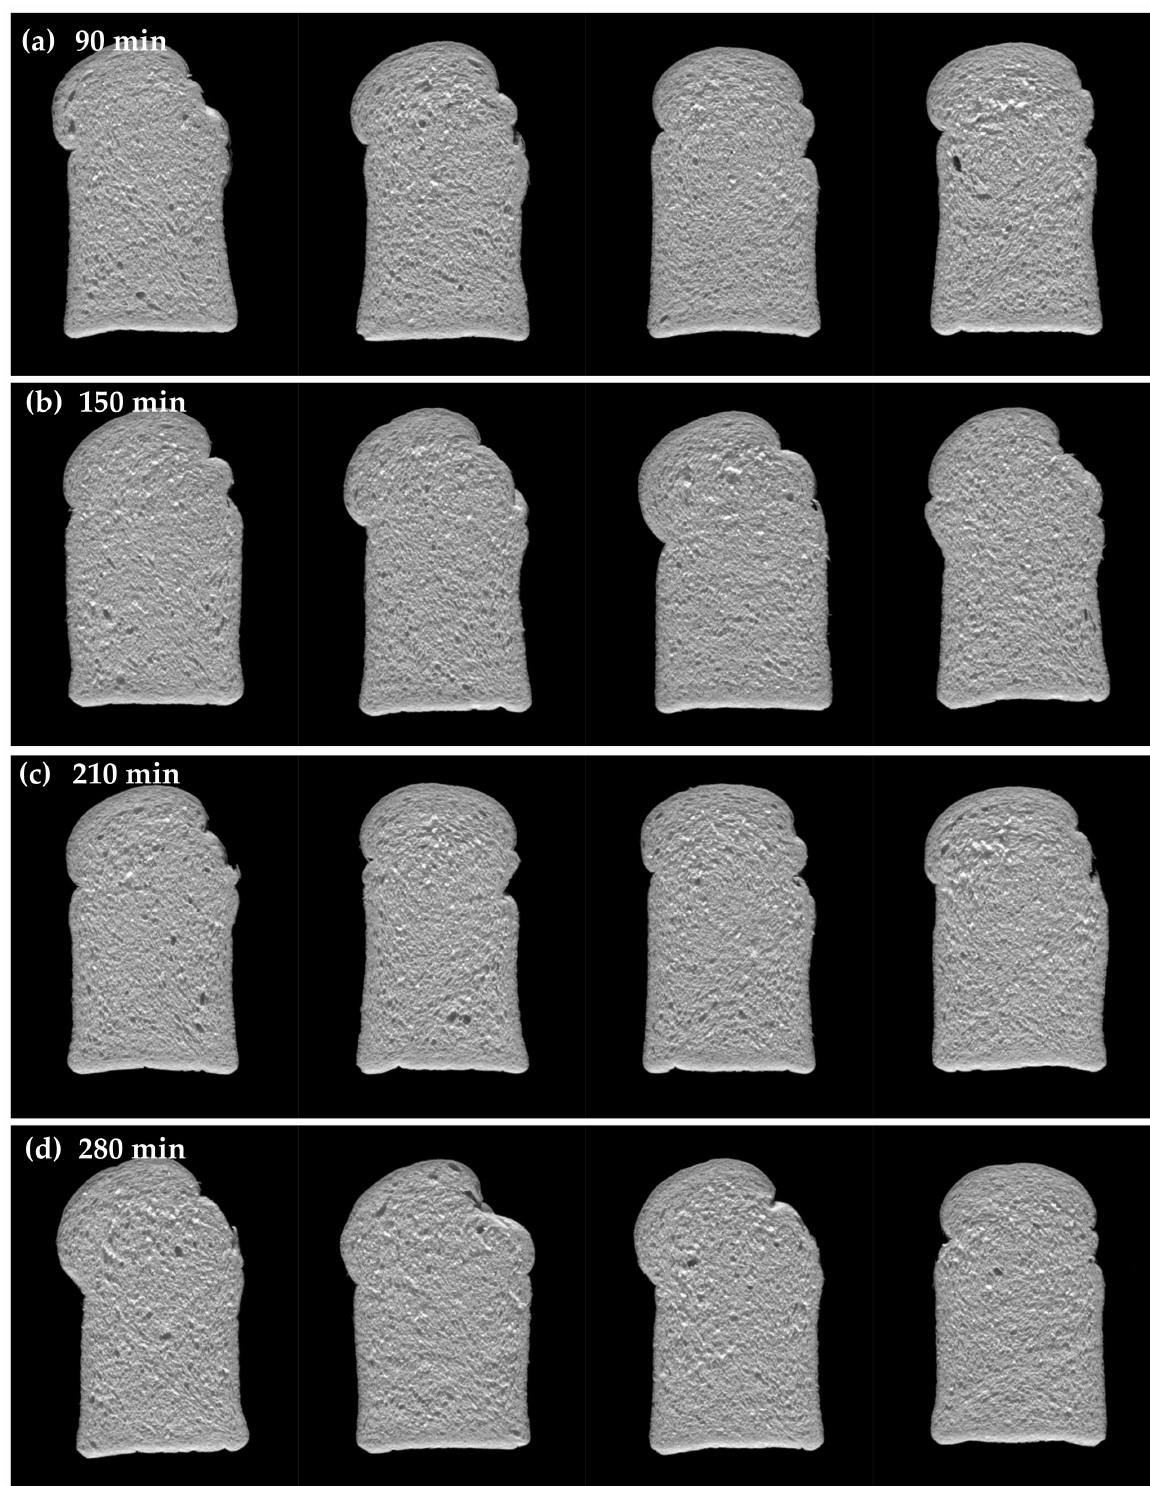
Figure 9. Slices of bread made with ferment prepared using varying fermentation times. ( a ) 90 min, ( b ) 150 min, ( c ) 210 min, and ( d ) 280 min. Left to right: control (no ferment), 30% ferment inclusion, 50% ferment inclusion, and 70% ferment